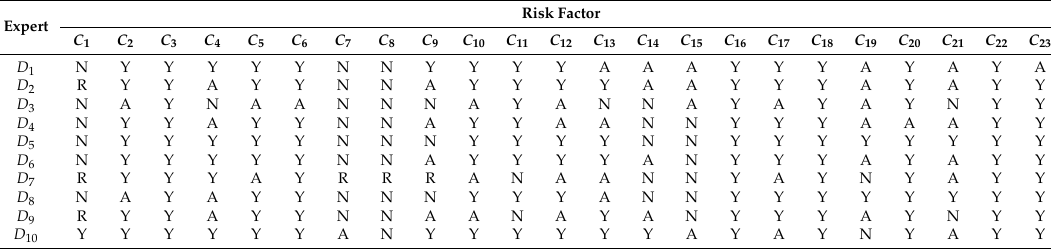
Table 7. Linguistic importance evaluations of the risk factors.